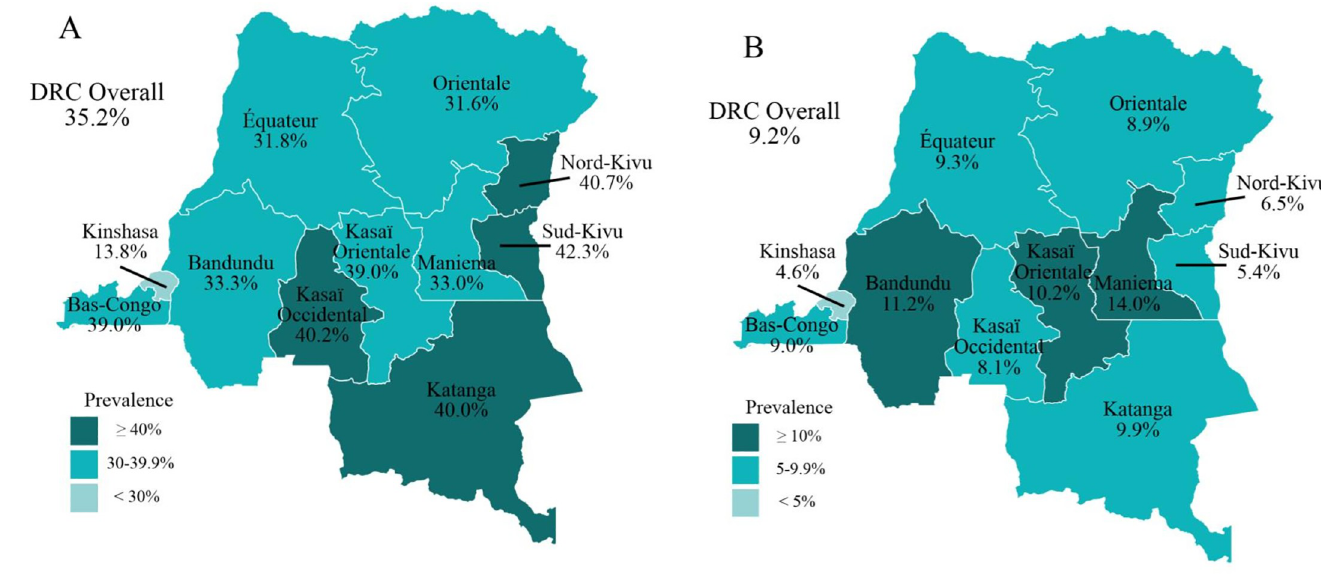
Fig 2. Map of the Democratic Republic of the Congo depicting the prevalence rates of stunting and wasting in children under age five by province. A) shows the percent of children under age five who are stunted by province. B) shows the percent of children under age five who are wasted by province.